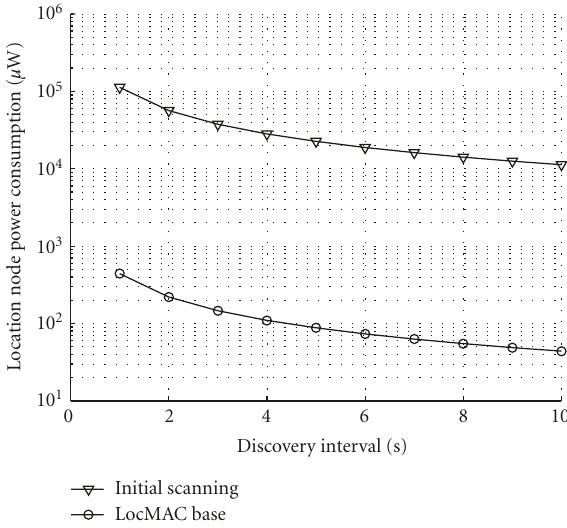
Figure 16: Power consumptions of LocMAC and initial scanning as a function discovery interval (i.e., beacon cycle length for locMAC and scan interval for scanning).